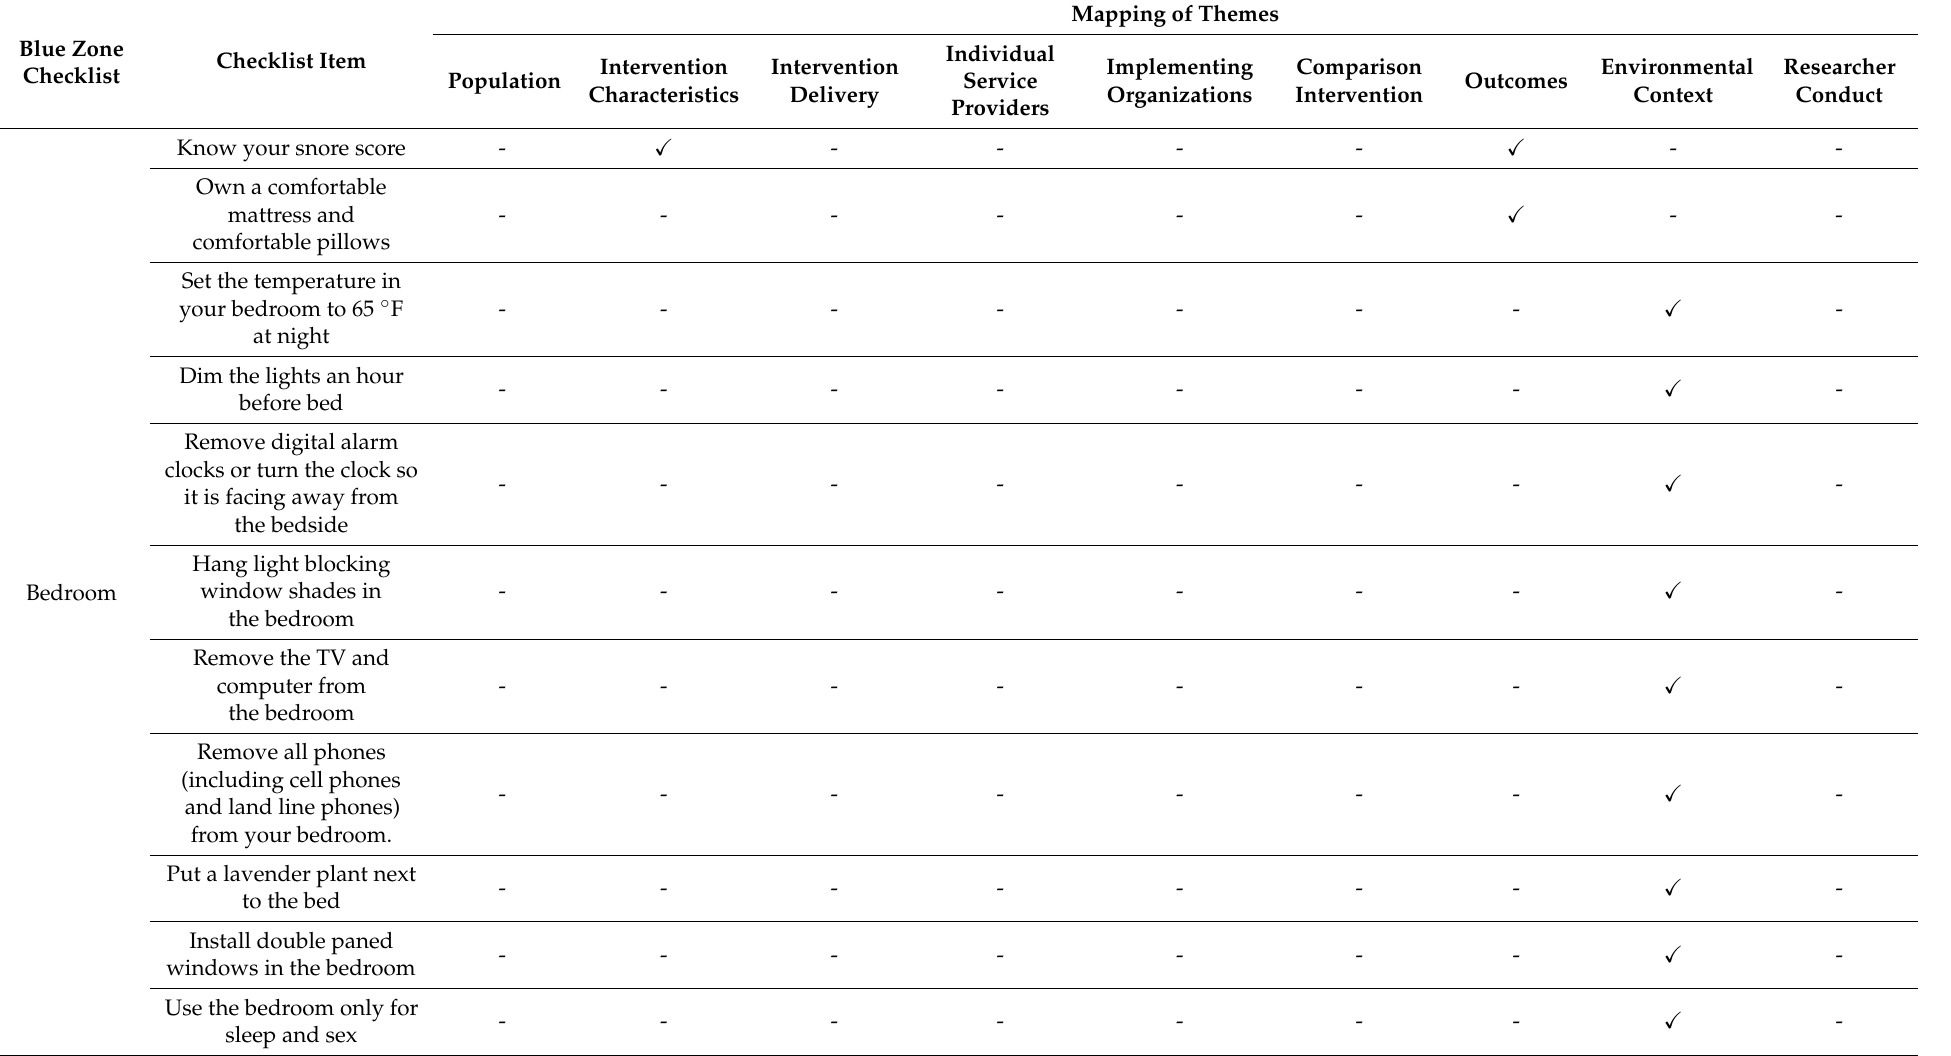
Table 10. Critical review of the “Bedroom” checklist based on the systematic mapping by Munthe-Kaas et al. [60].